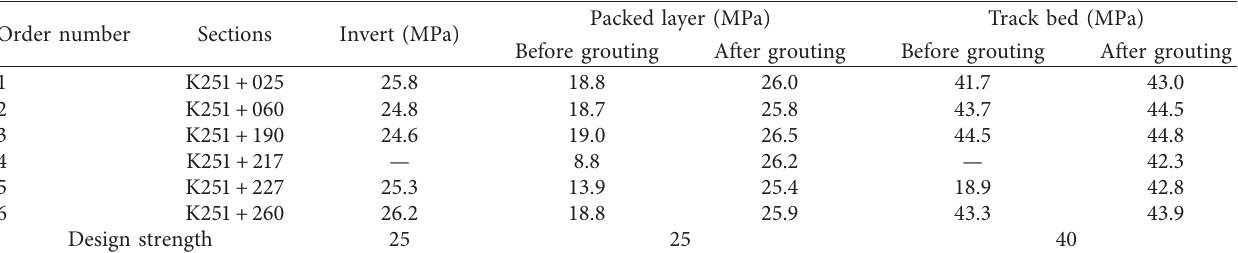
Table 12: Compressive strength of trial lot before and after